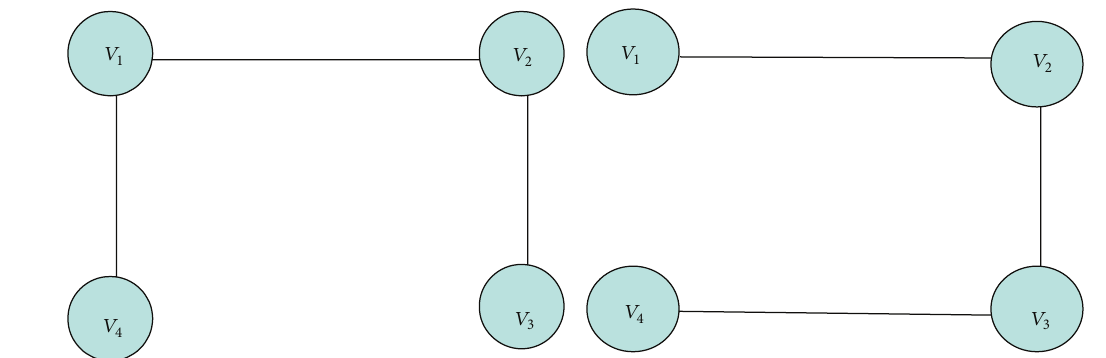
Figure 2: Two examples of undirected connected